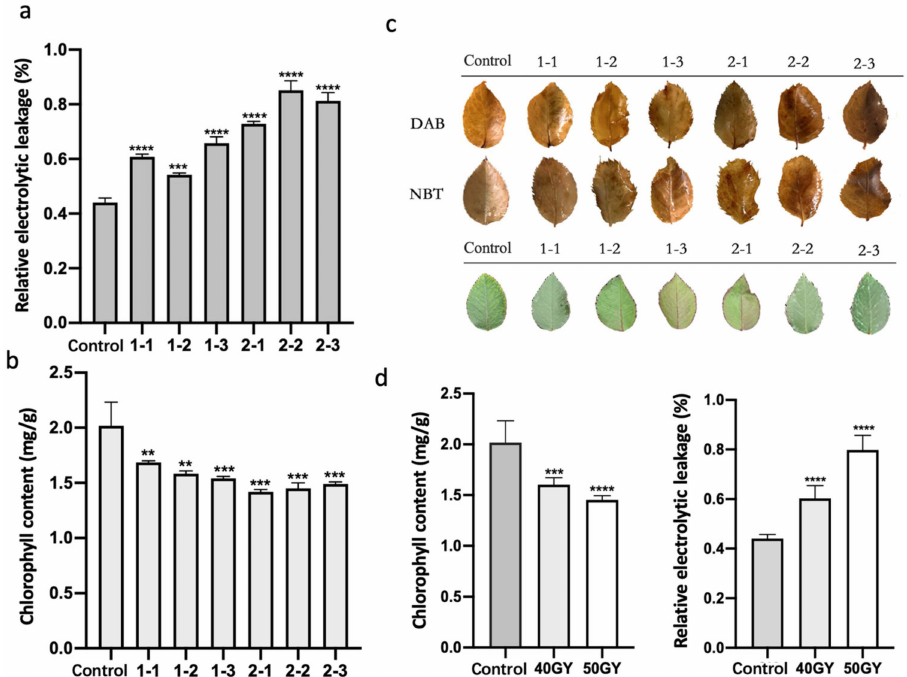
Figure 2. Physiological and biochemical indices of leaves from Rosa multiflora ‘Libellula’ plants irradiated with 60 Co γ -rays: ( a ) relative electrolytic leakage in leaves; ( b ) leaf chlorophyll contents; ( c ) DAB and NBT staining results and changes in chlorophyll accumulation; ( d ) total chlorophyll contents and relative electrolytic leakage after the 40 and 50 Gy irradiation treatments. Asterisks indicate significant differences among treatments (** p < 0.01; *** p < 0.001; **** p < 0.0001). The vertical bars indicate the standard deviations of the means of three